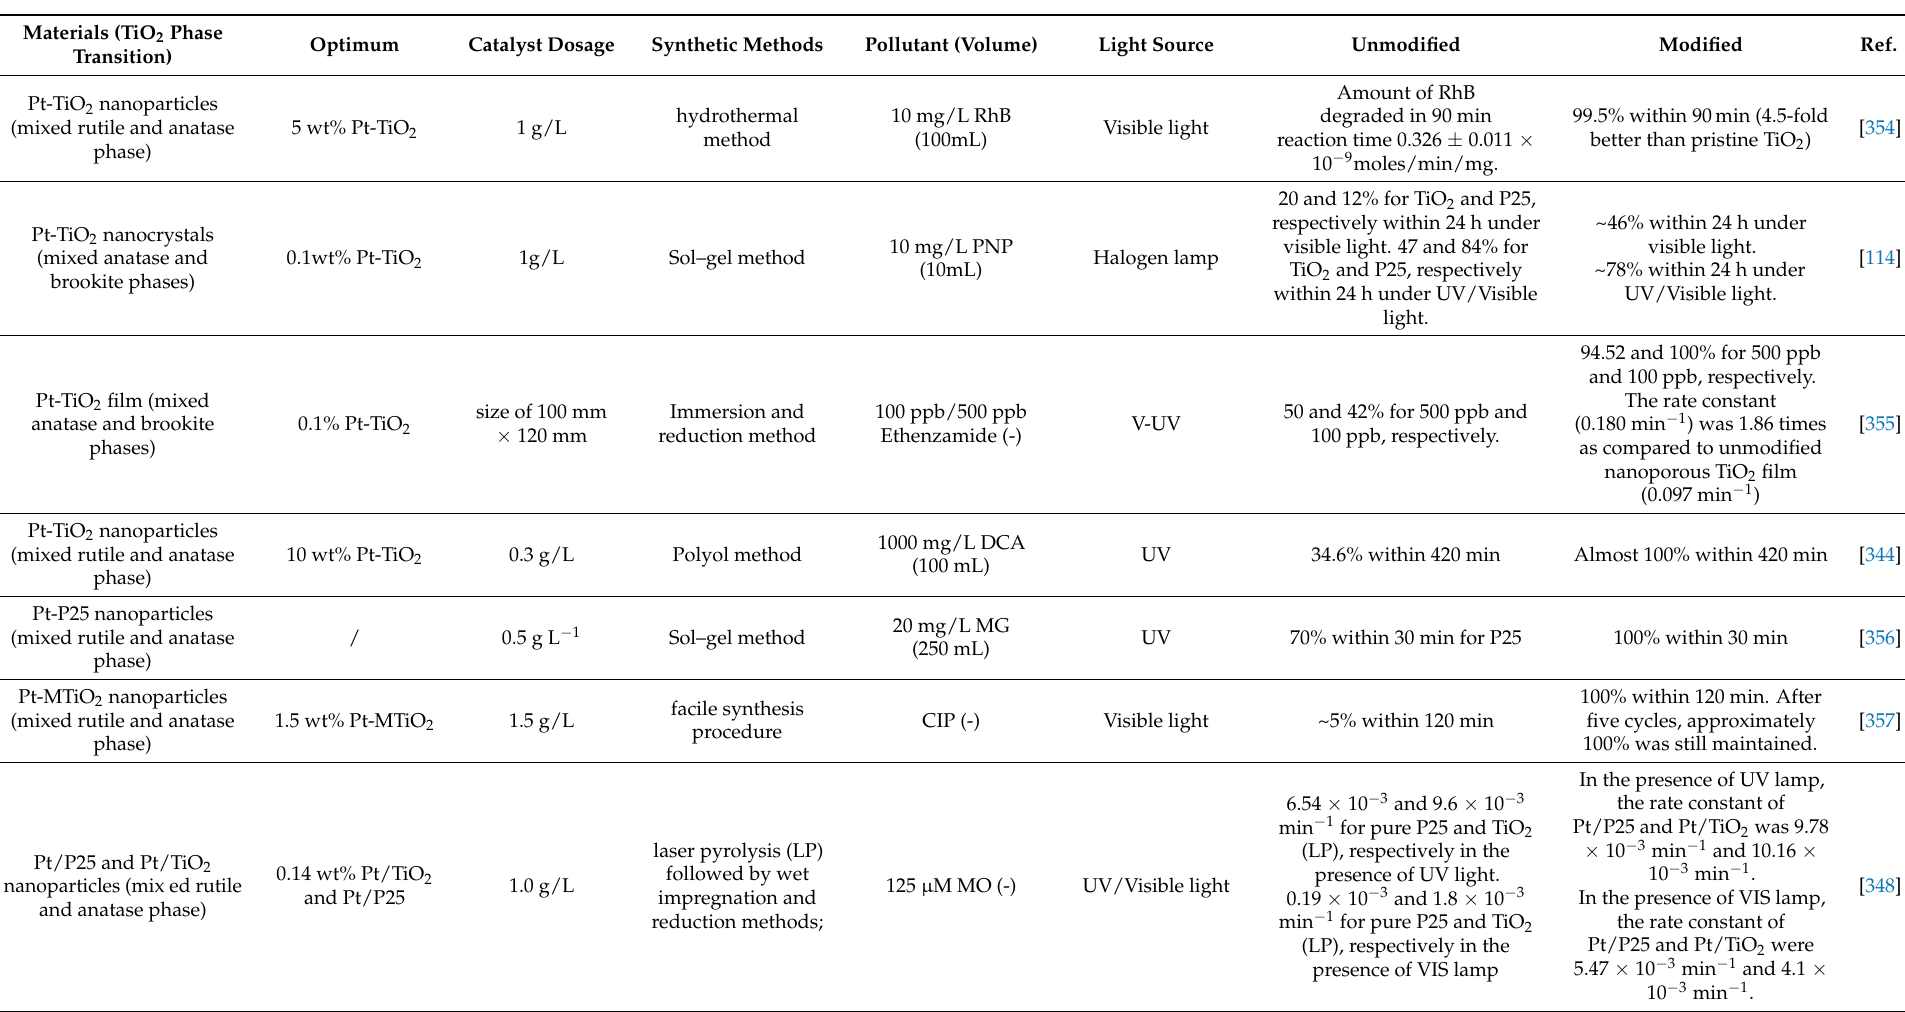
Table 17. Summary of recent progress on Pt-TiO 2 photocatalysts for organic pollutants